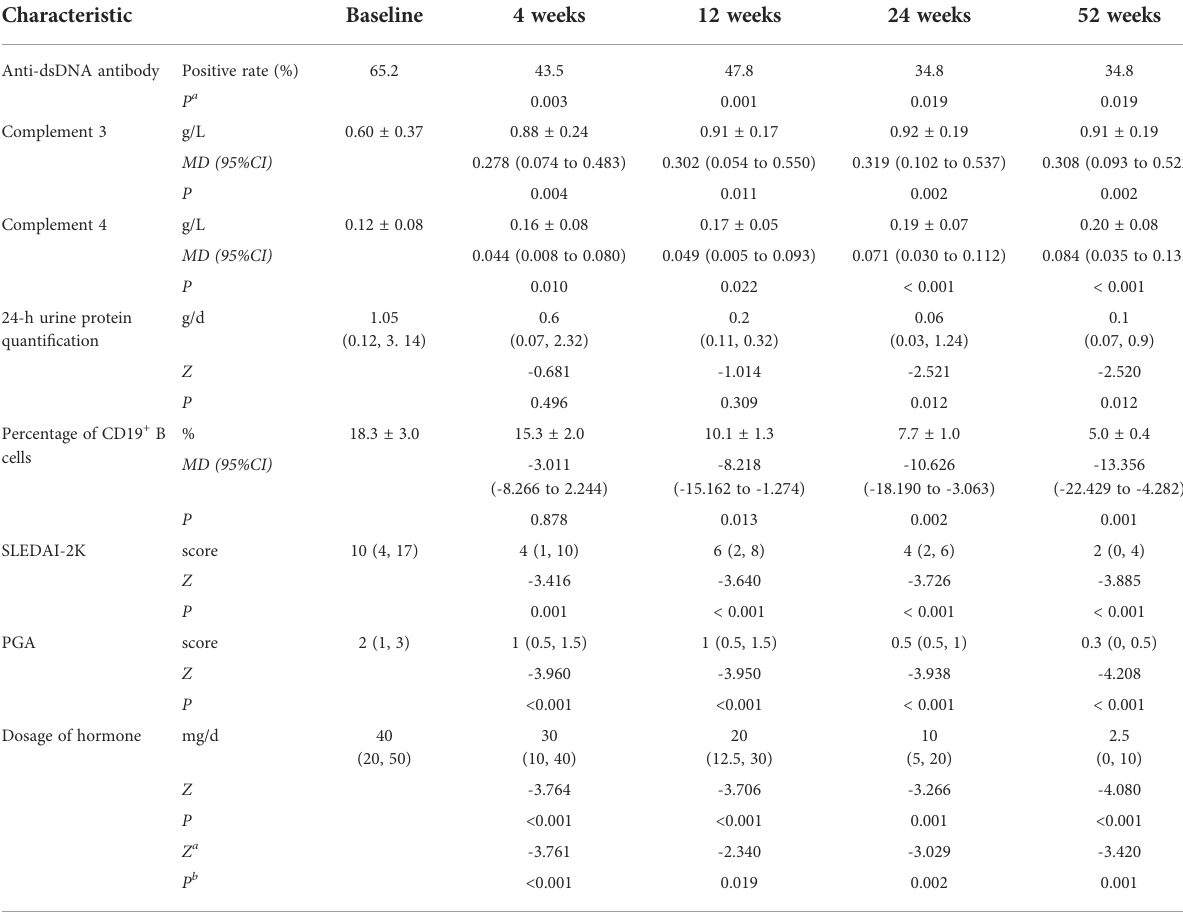
TABLE 2 Comparison of the laboratory tests, disease activity, and hormone dosage during the different periods of belimumab treatment (up to 52 weeks) in 23 childhood-onset systemic lupus erythematosus patients.